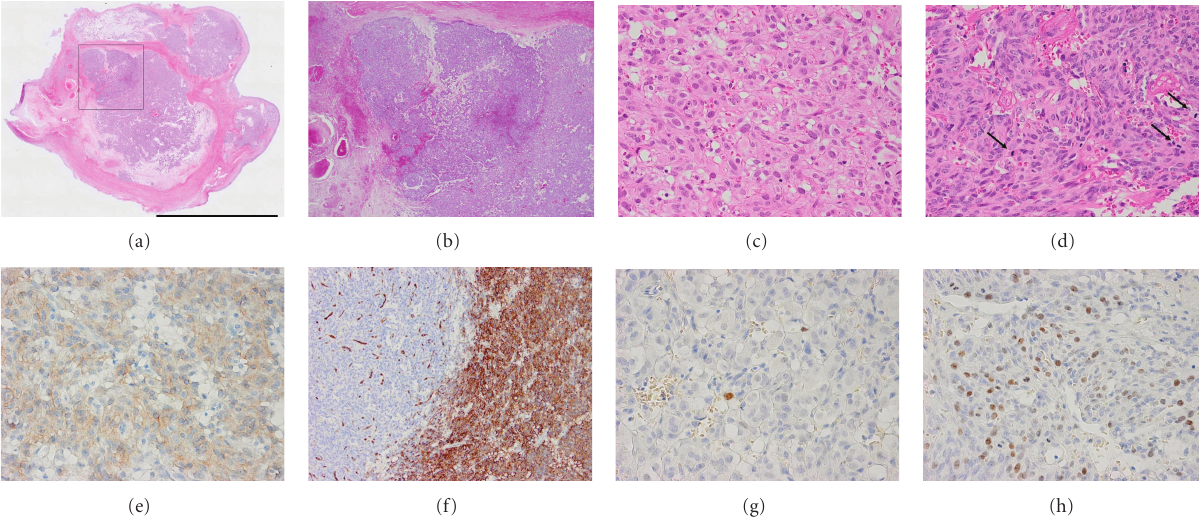
Figure 1: Light microscopic findings. (a) Whole-mount section of the tumor, with the ulcerated mucosal area to the left (hematoxylin and eosin, HE); bar, 1cm. The area within the box is shown at a higher magnification in (b). (b) Highly aggressive tumor cells forming a demarcated area in the center, which is the only area where necrosis and hemorrhage were observed. The other areas comprised the less aggressive tumor cells (HE). (c) Higher magnification of the less aggressive tumor cells. The admixture of epithelioid and short spindle cells is shown (HE). (d) Higher magnification of the highly aggressive tumor cells. Note the higher cellular density and mitotic activity compared with (c). Mitotic activity is indicated by arrows (HE). (e) Tumor cells were immunopositive for KIT, irrespective of the area (KIT immunohistochemistry). (f) A clear demarcation line is shown by CD34 immunostaining. The positive and negative areas correspond to the less and highly aggressive tumor cells, respectively. (g) A low Ki-67 index is observed in the less aggressive areas. (h) A high Ki-67 index is observed in the highly aggressive